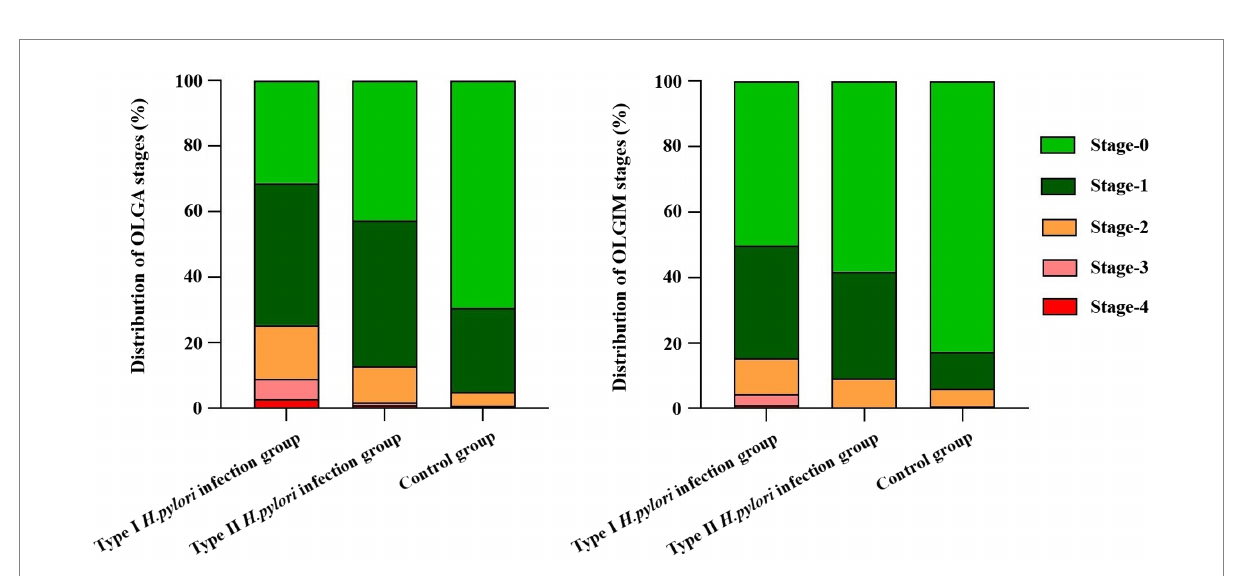
FIGURE 4 Different types of Helicobacter pylori infection in OLGA and OLGIM staging